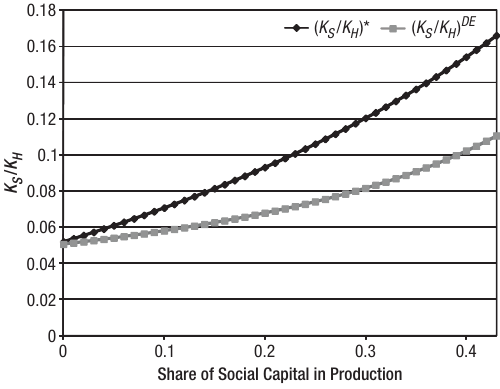
Fig. 1. Comparison between ( K